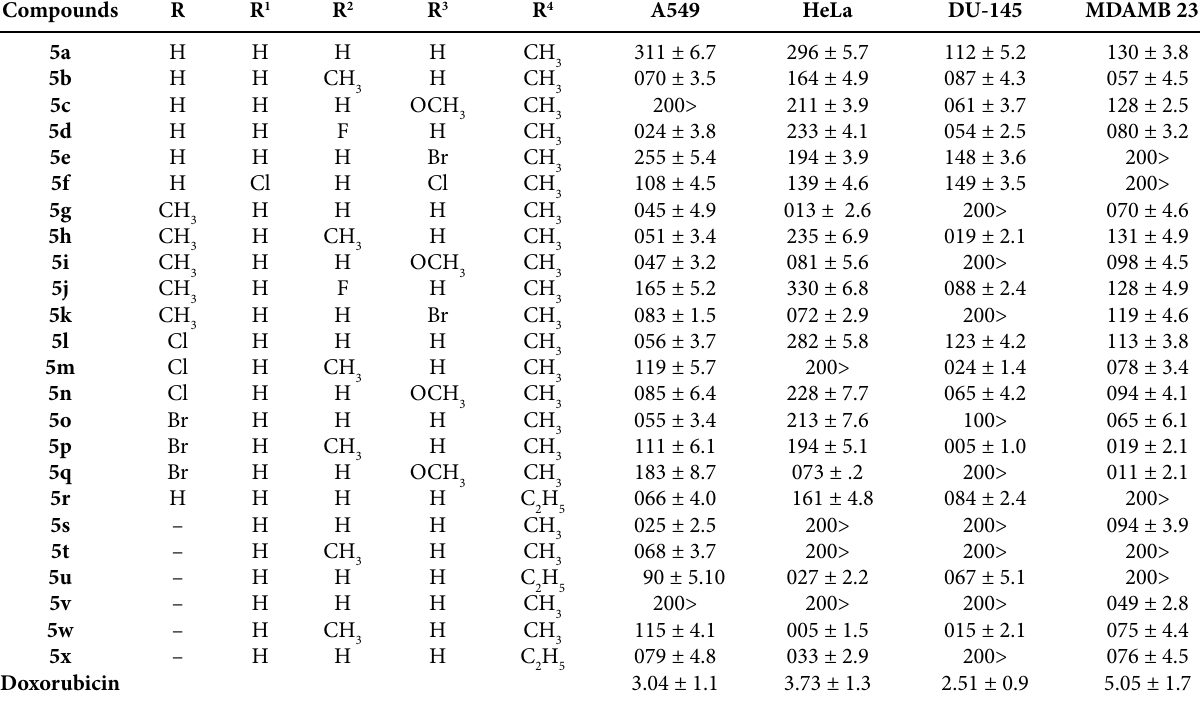
Table 2 . Anti-proliferative activity of pyrazolecarboxylates